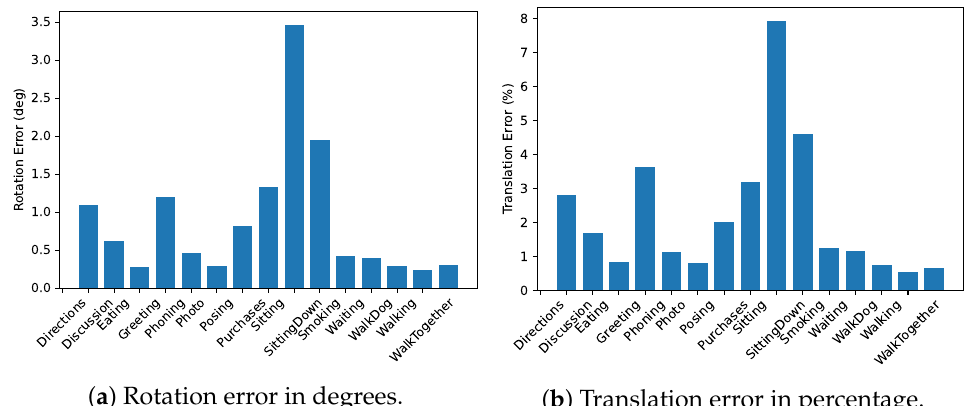
Figure 4. The rotation error and translation error of the 15